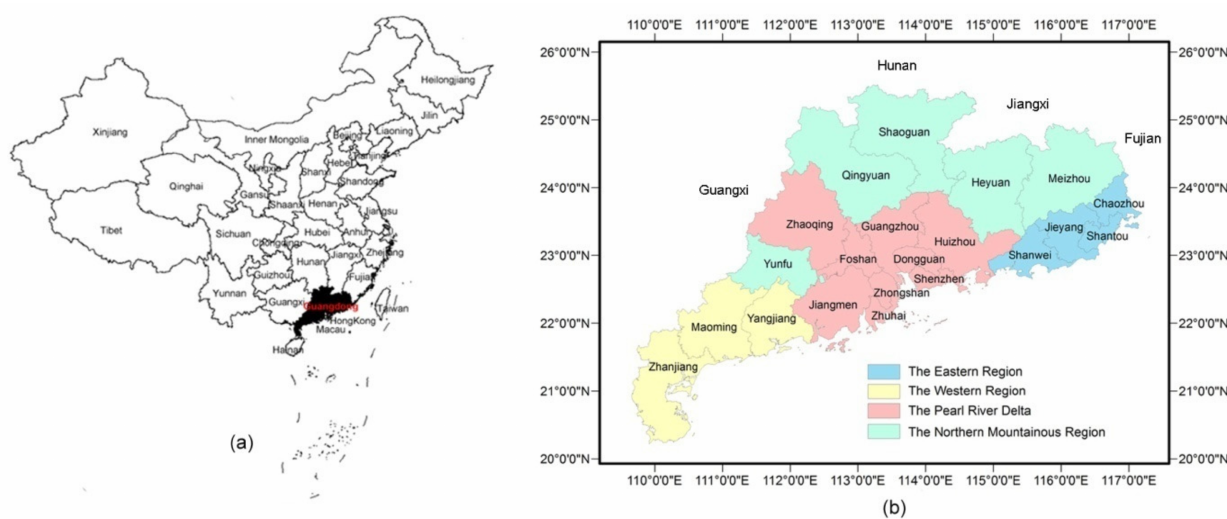
Figure 1. Location of Guangdong province, China. ( a ) Map of China (source: www.travelchinaguide.com (accessed on 20 June 2020)); ( b ) Four regions of 21 prefecture-level cities of Guangdong